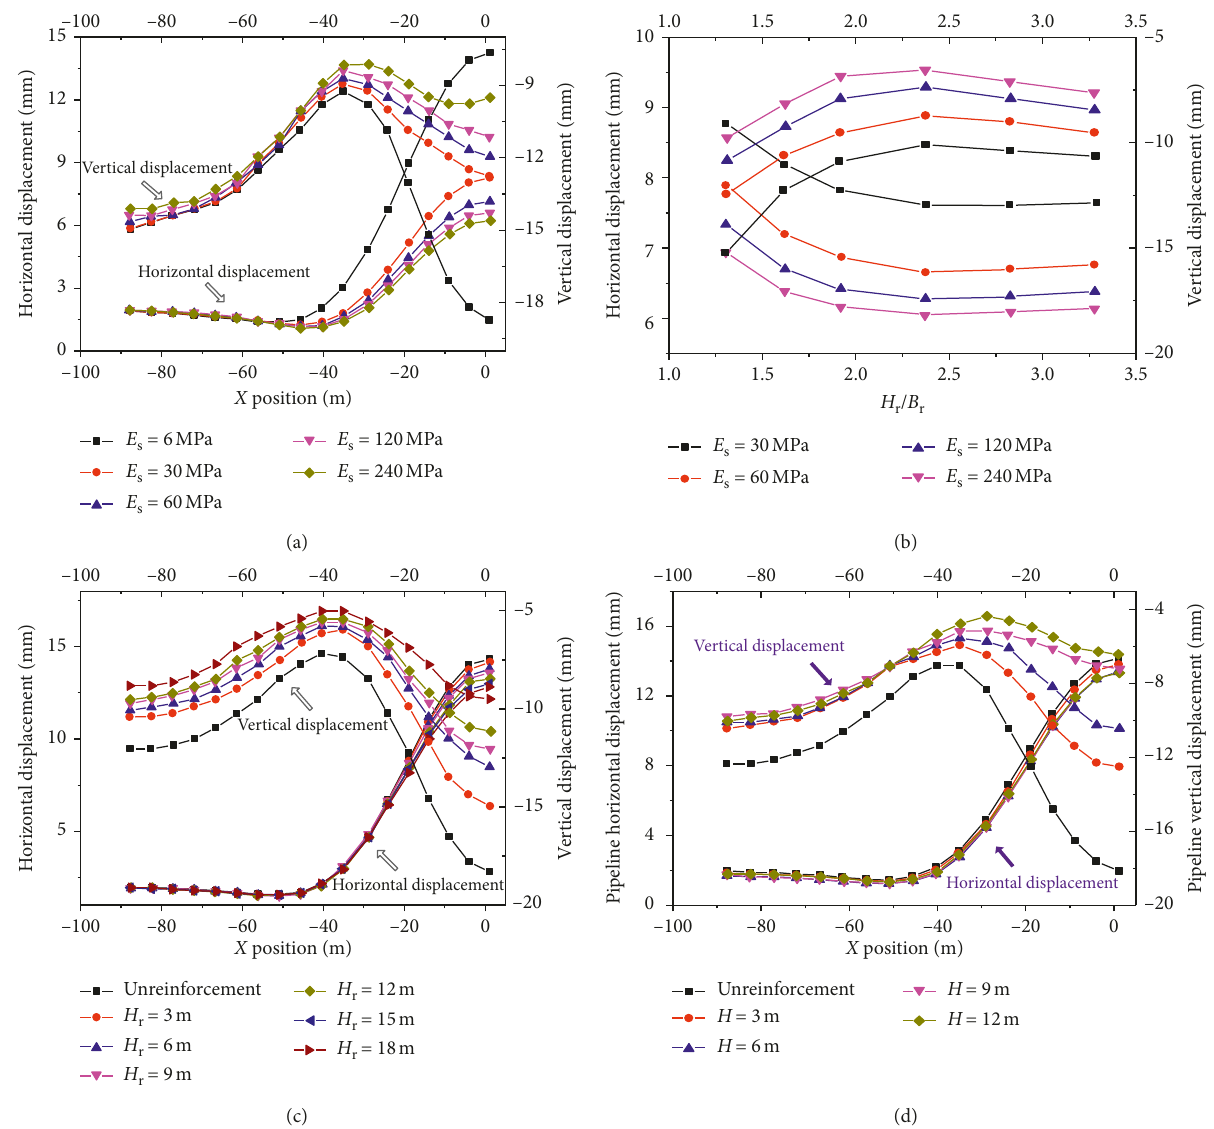
Figure 12: (a) The pipeline displacement regularity. (b) The maximum displacement of underground pipelines with ratio of the RS depth to the RS width changes. (c) The pipeline displacement regularity by the RS underneath pipeline. (d) The pipeline displacement regularity by the RS between pipeline and